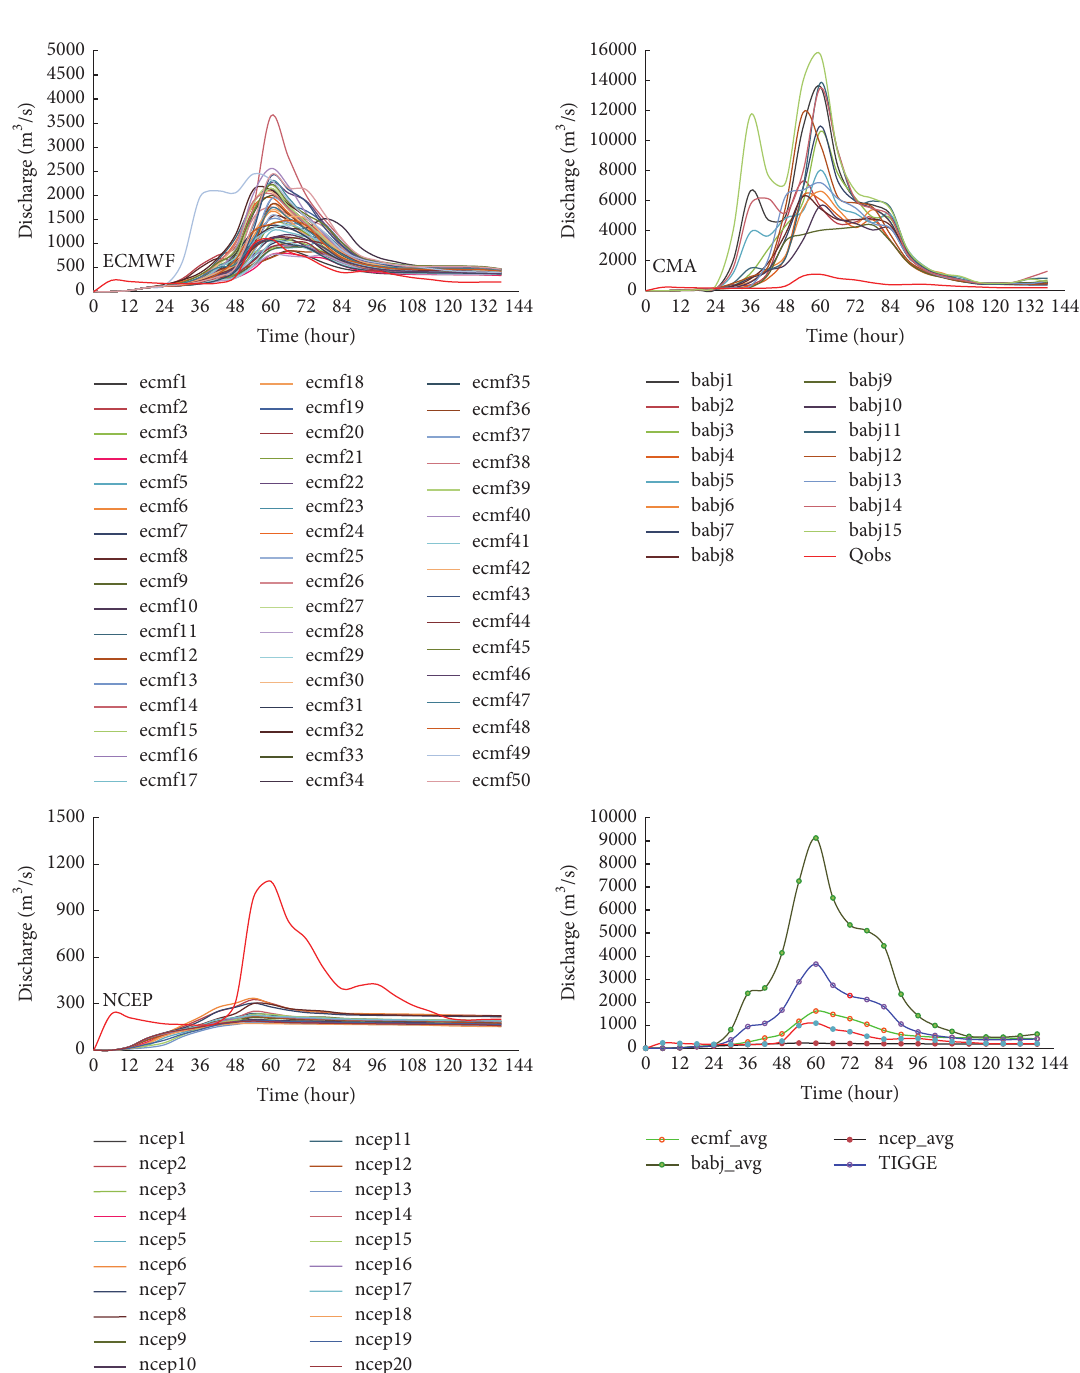
Figure 3: Same with Figure 2 except for forecasted